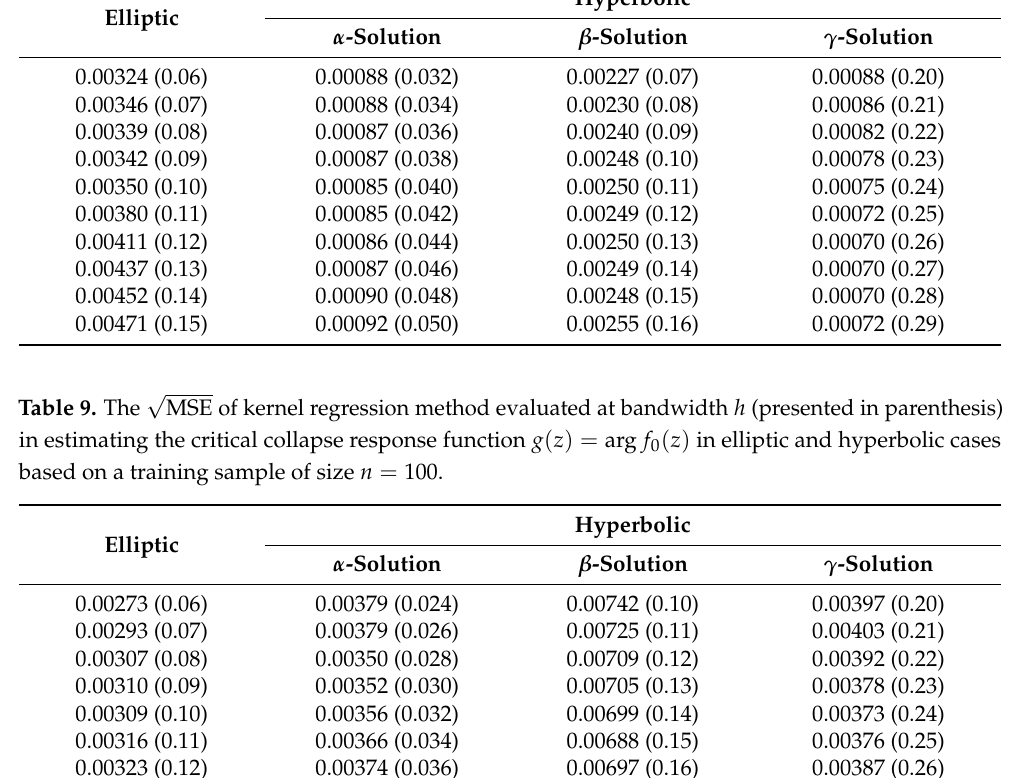
( z ) − z 2 in elliptic and hyperbolic cases 0